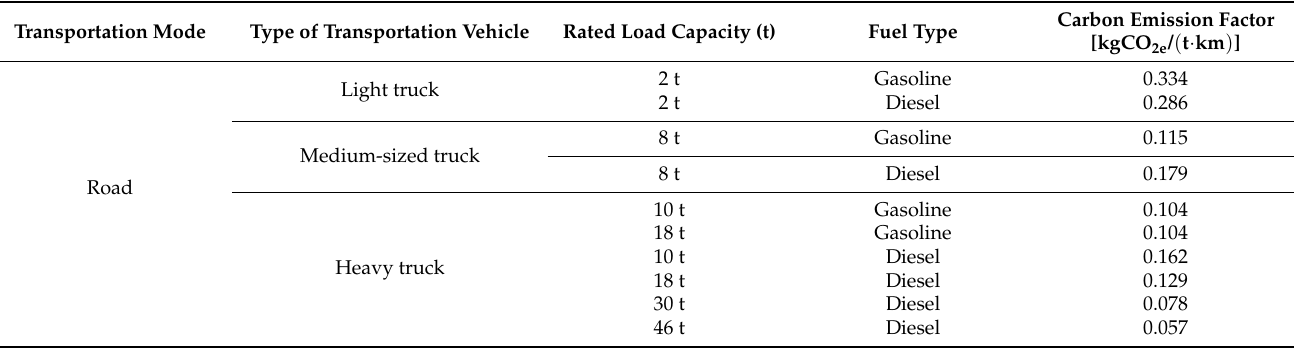
Table 4. Summary of carbon emission factors for each type of